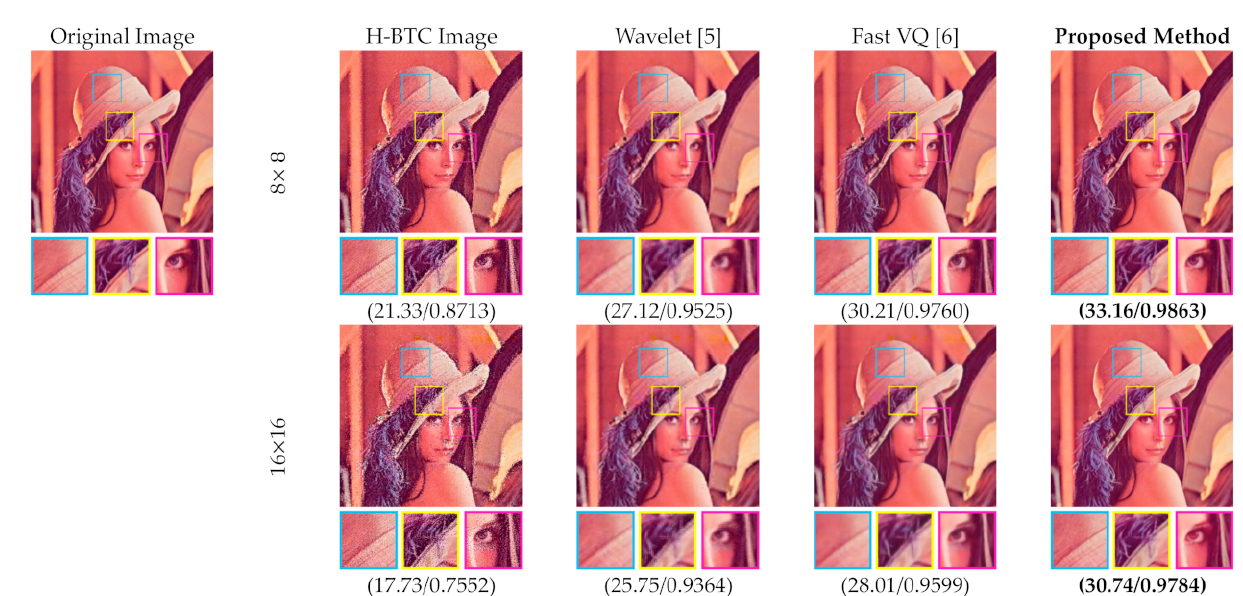
Figure 15. Visual comparisons between the proposed method and former schemes on reconstructing the DDBTC decoded image over the Lena image.